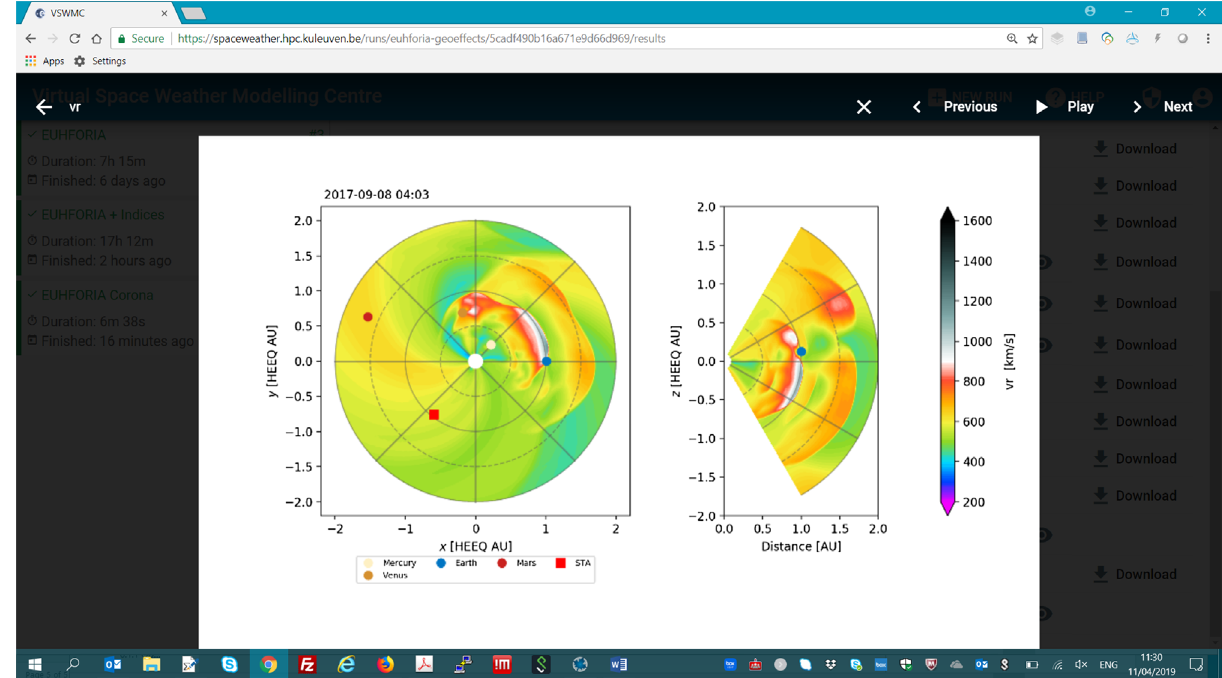
Fig. 10. Example screenshot of the radial velocity in the equatorial plane (left) and meridional plane of the Earth (right).